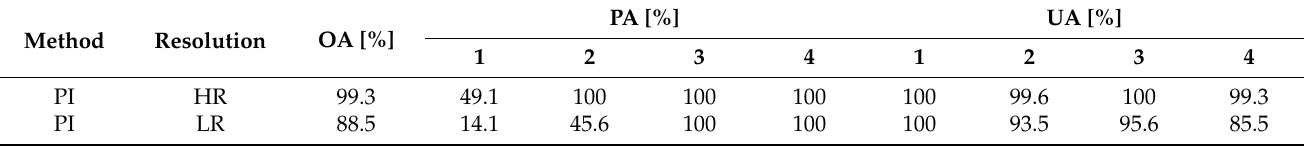
Table 2. Results of the accuracy assessment of the image classification performed through photo-interpretation (PI); the accuracy metrics are reported for the PI of the high-resolution (1 cm; HR) and low-resolution (20 cm; LR) images and included the overall accuracy (OA), the producer’s (PA) and user’s accuracy (UA) of each classification class (1: larches; 2: brownish shrubs; 3: greenish shrubs; 4: